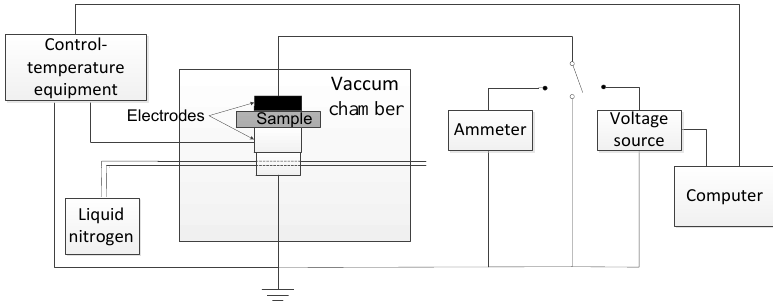
Figure 3. The schematic diagram of the thermally stimulated current measurement system.